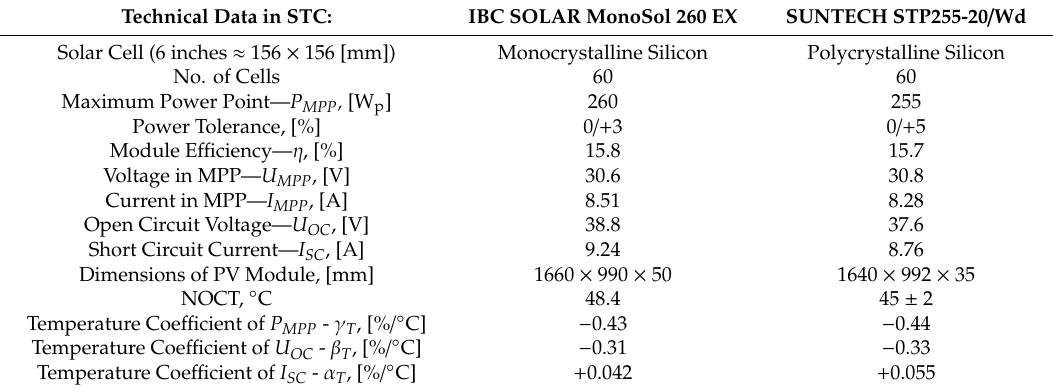
Table 1. Selected technical data of the PV modules according to the manufacturers.